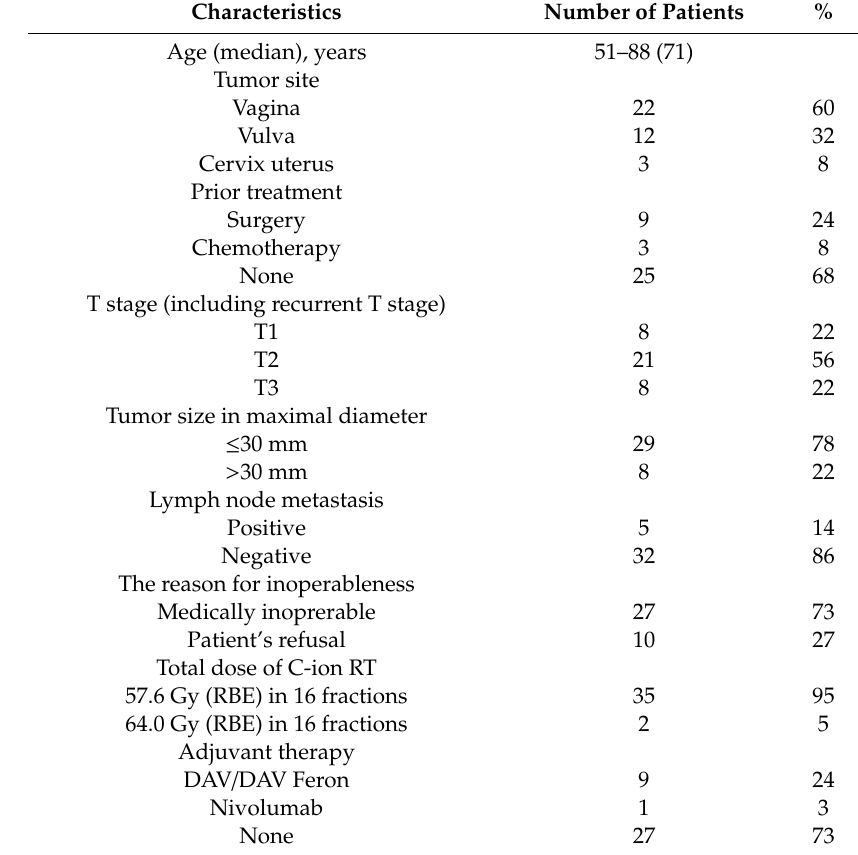
Table 1. Patient and tumor characteristics ( n =